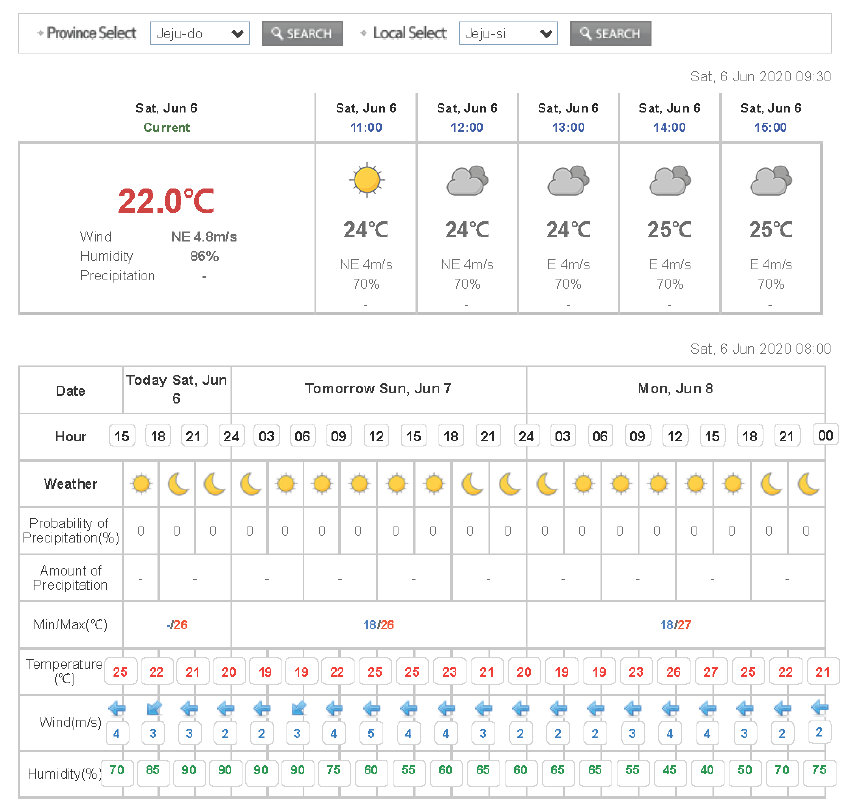
Figure 1. Short-term weather forecast by the Korea Meteorological Administration.